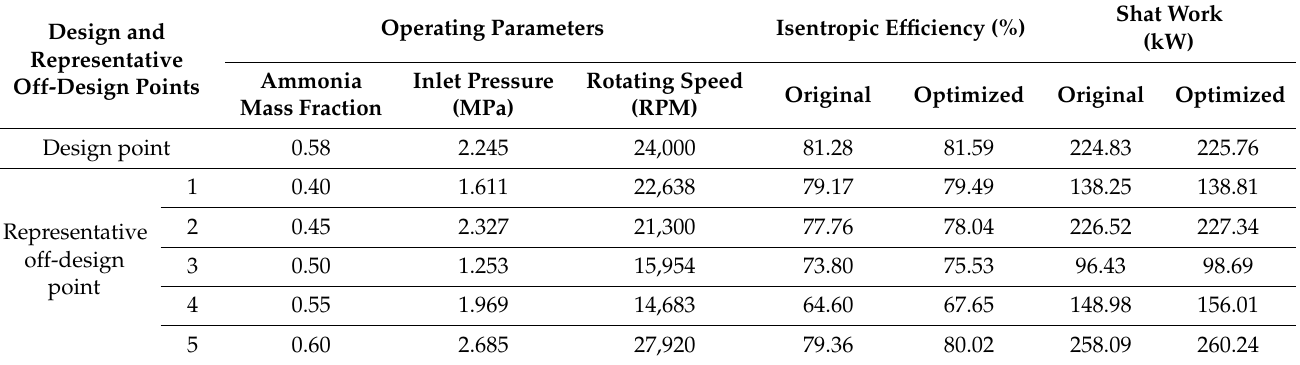
Table 6. Optimized turbine off-design performance.